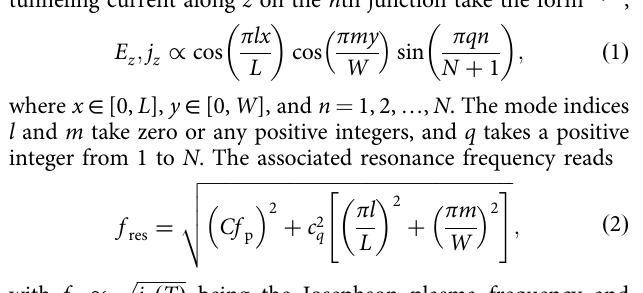
Fig. 1 Schematic of the superconductor BSCCO with intrinsic Josephson junctions. a Atomic structure in which the CuO 2 planes are superconducting. b Equivalent circuit. Each discretized element is characterized by the Josephson critical current I c , c -axis resistance R c , c -axis capacitance C c , ab -plane resistance R ab , and ab -plane inductance L ab , which is associated with the in-plane supercurrents and dominantly kinetic in origin. Additional geometric inductances could be added in series to R ab but are neglected. The discreteness along z is naturally set by the layered structure, whereas the element sizes along x and y are in theory in fi nitesimal, d x , d y → 0. In the numerical simulation, d x and d y are fi nite but smaller than the Josephson length λ J . Here we chose d x = d y = 0.5 μ m, which is roughly a factor of 2 below λ J . c A typical rectangular-shaped 3D junction stack of length L , width W , and height H